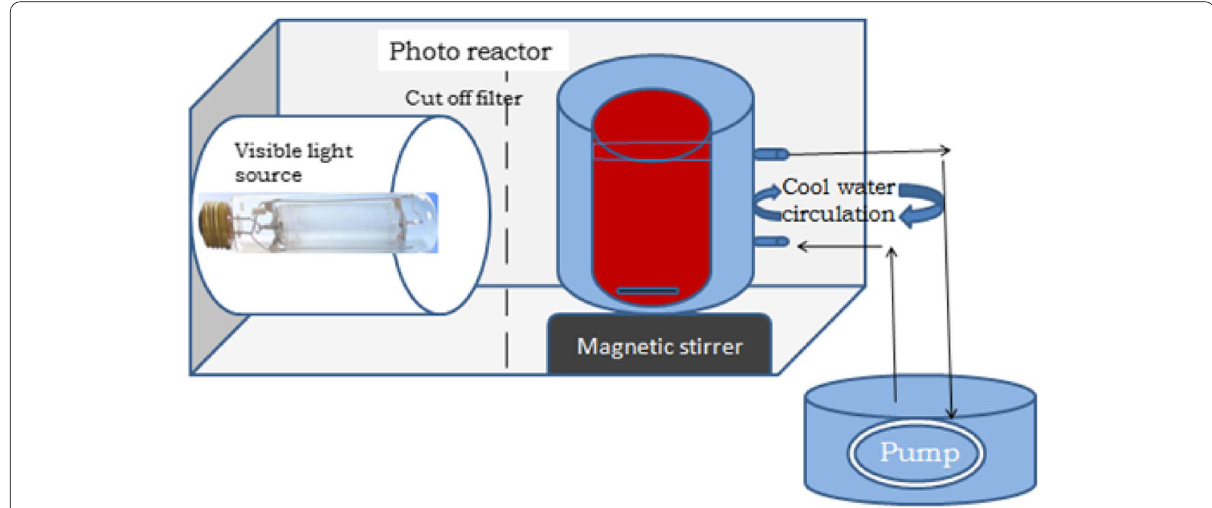
Fig. 2 Schematic representation of photo